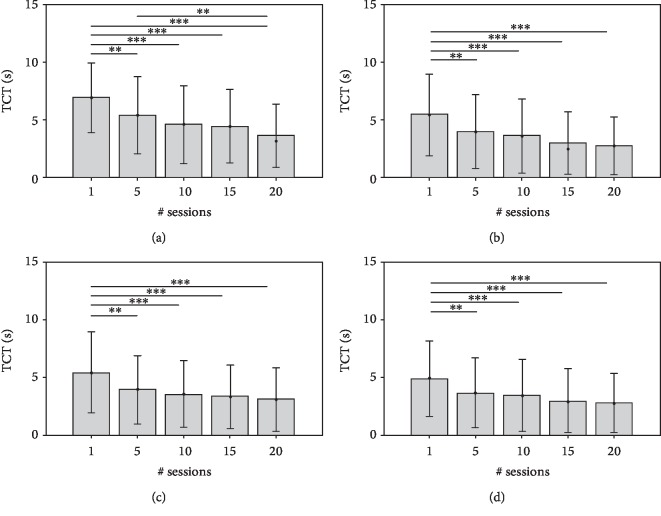
TCT values (mean and standard deviation) at 1st, 5th, 10th, 15th, and 20th sessions of RT and significant post hoc comparisons between sessions (Conover's test): ∗p value < 0.05; ∗∗p value < 0.001; ∗∗∗p value < 0.0001. The data obtained by analysing the end-effector trajectories towards the four targets (A, B, C, D) are showed separately.